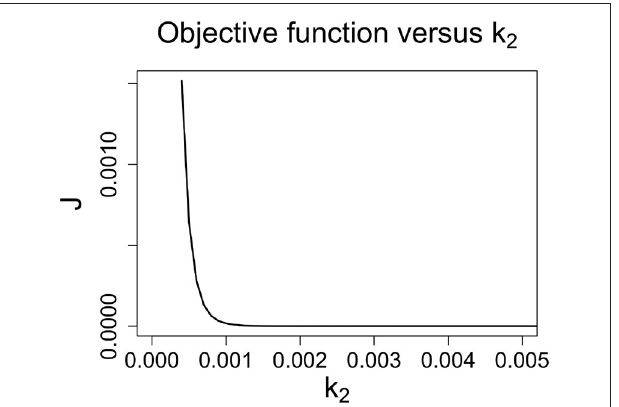
FIGURE 3 | Sensitivity ranges of the concentration c ( t ) for 100 combination of parameters k 1 , k 2 and h . We select the Latin hypercube sampling algorithm (see the R code in Table 2 ).